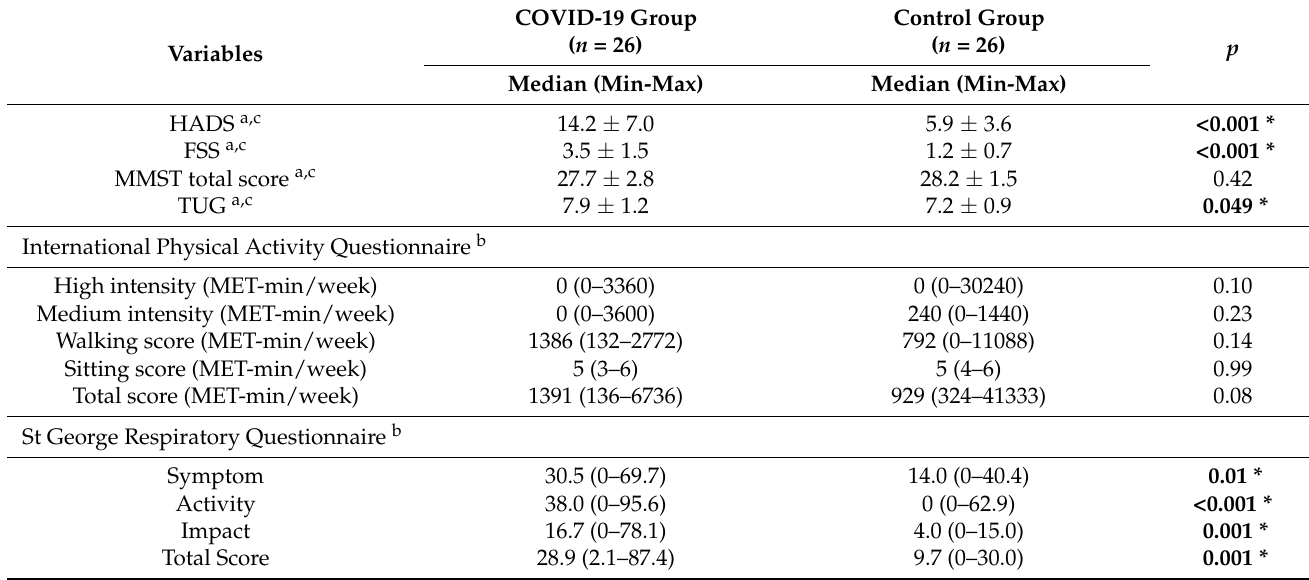
Table 2. Comparison of MMST, HADS, FSS, TUG, physical activity, and quality of life in COVID-19 and control